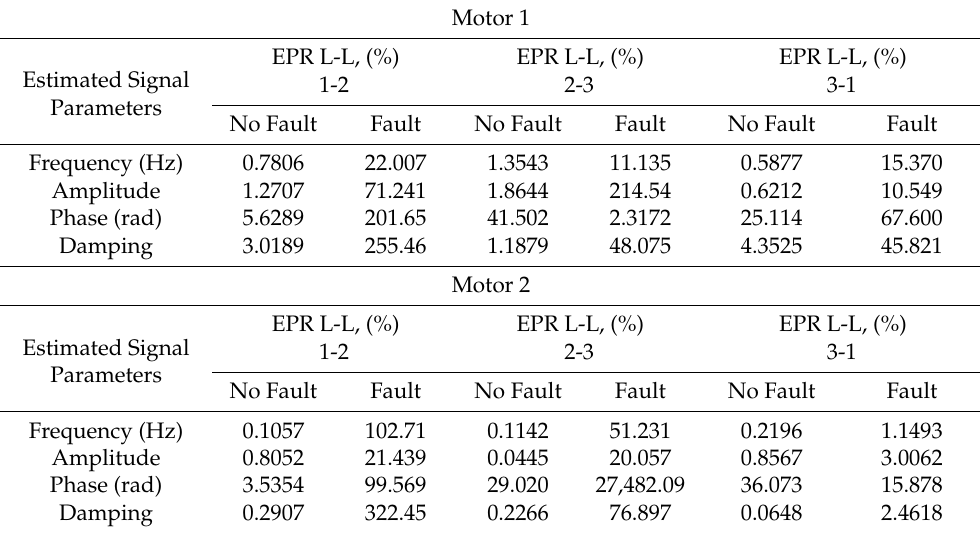
Table 7. Error parameter ratio percentage of real surge waveforms. (No fault and Fault).